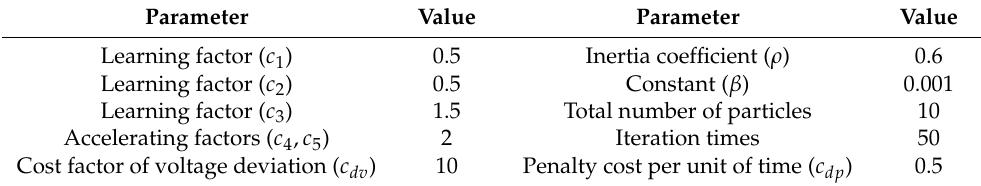
Table A6. Parameters of algorithm, objective function, and constraints in mathematical models.